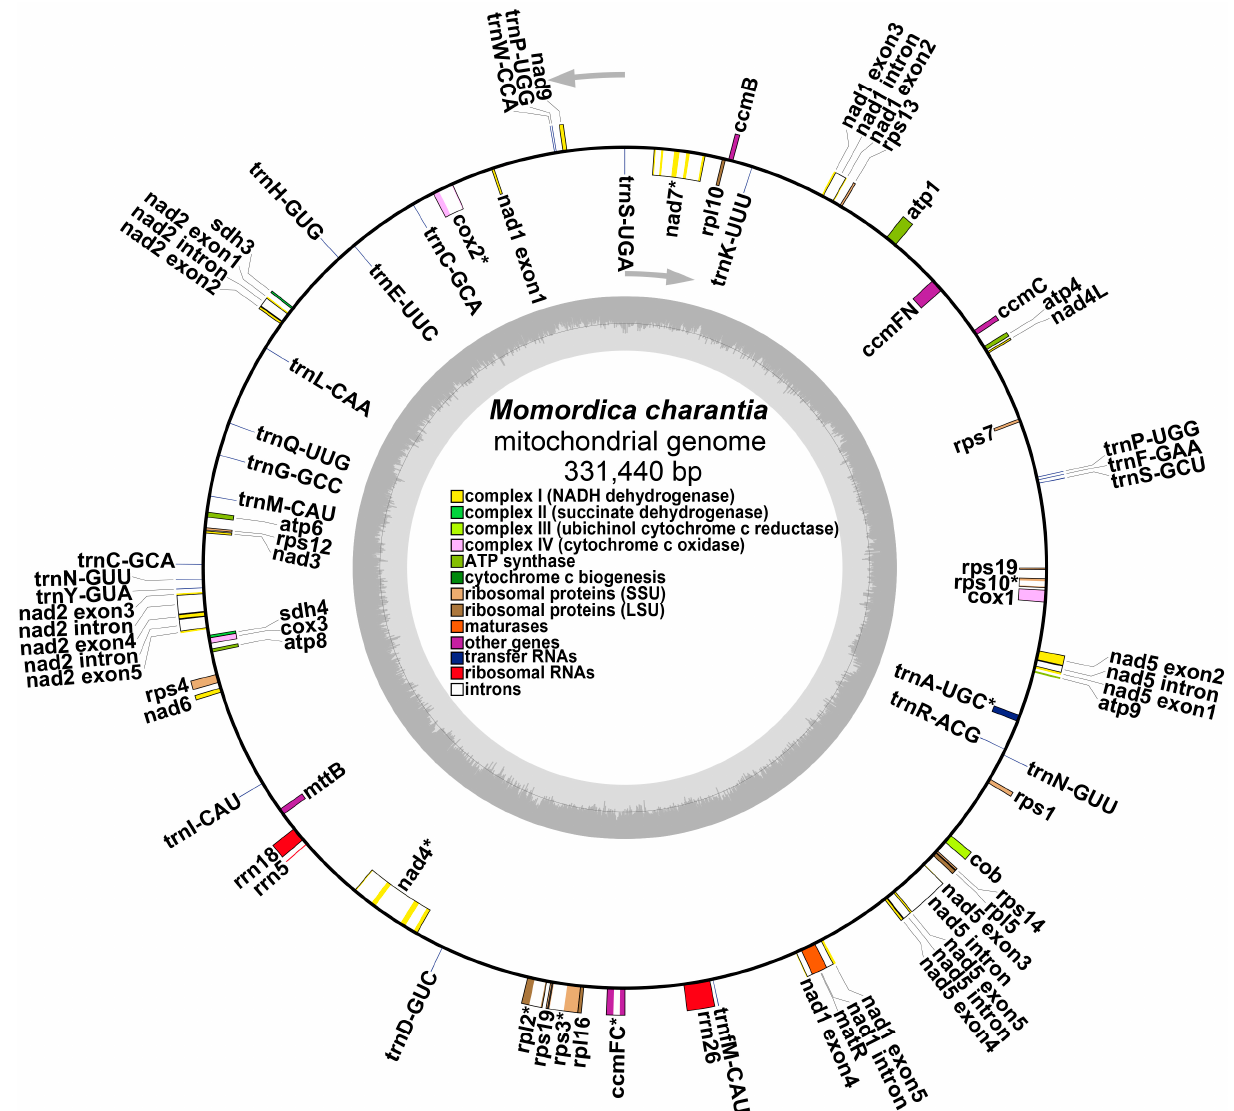
Figure 1. Genome circle map representing the mitochondrial genome of Momordica charantia . The colored squares inside and outside the circle represent various mitochondrial genes. Genes belonging to the same function are represented by the same color. Genes nad1, nad2, nad5, etc. are represented in the form of multiple exons and introns. * Represents non-trans-sheared intron genes. The arrows represent the forward and reverse chains.